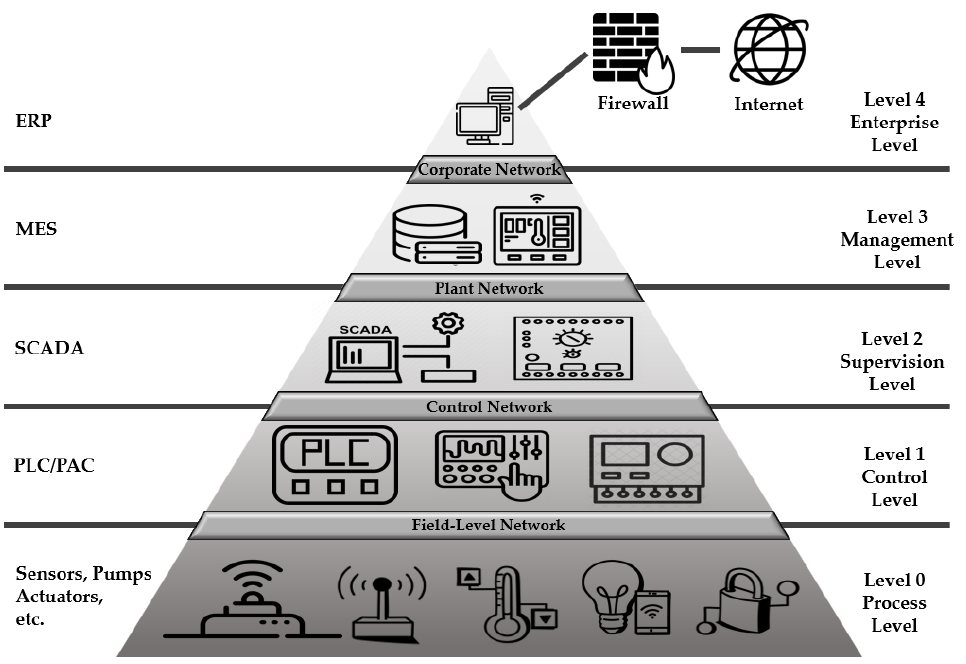
Figure 1. Structure of an ICS.